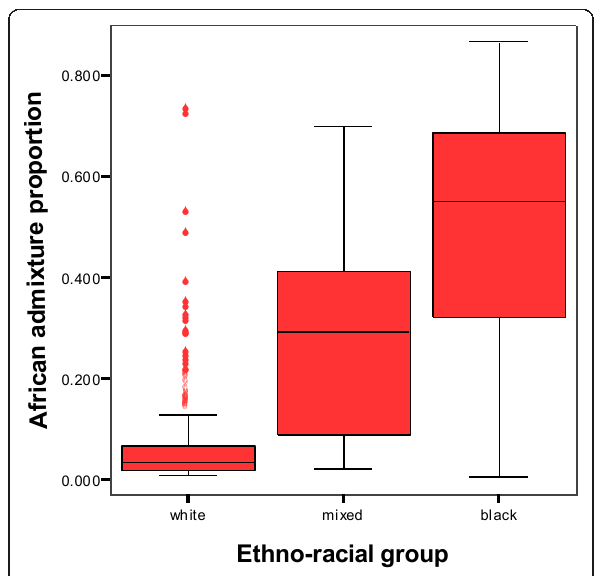
Figure 1 Box plot of African admixture distribution by ethnic identity (weighted) .